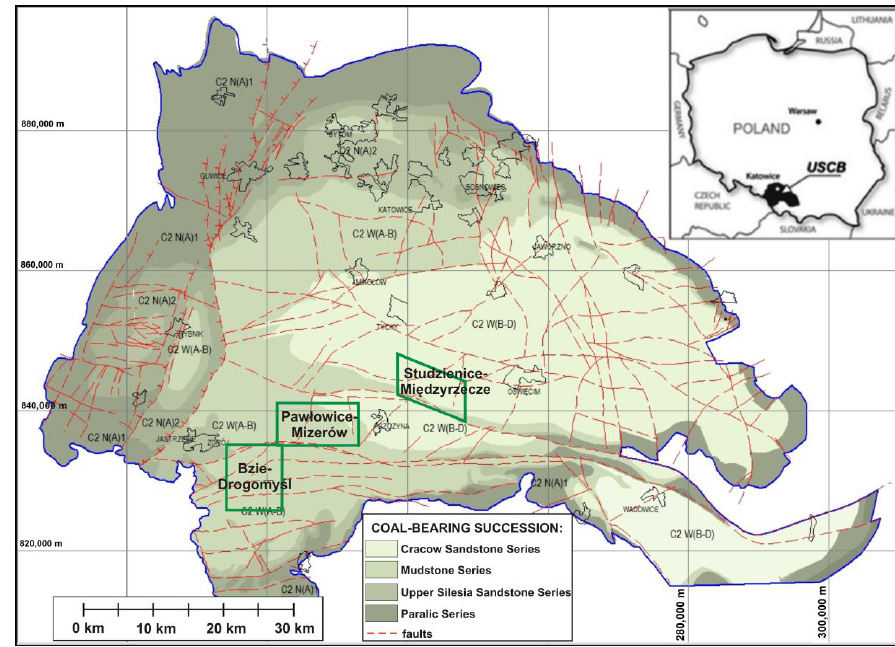
Figure 1. Location of the three enhanced coal bed methane (ECBM) promising regions selected for research on CO 2 storage in deep coal seams on the geological map of the Upper Silesian Coal Basin (USCB). Region Pawłowice–Mizer ó w comprising two coal seams, 405 and 510, was selected for the research activities. Coal seams 405 and 510 deposited at the depth of 1130 m and 2270 m characterize of average methane content of 4.2 m 3 CH 4 / Mg daf and 3.8 m 3 CH 4 / Mg daf , respectively. For the chosen